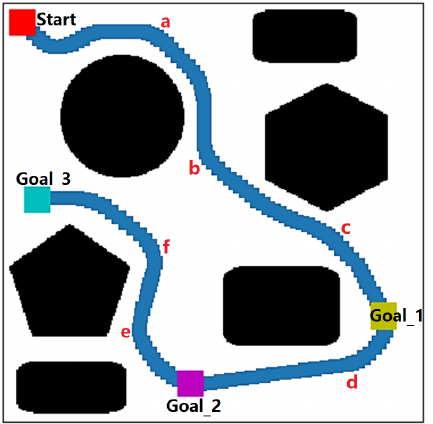
Figure 15. Multi-goal path planning in a static